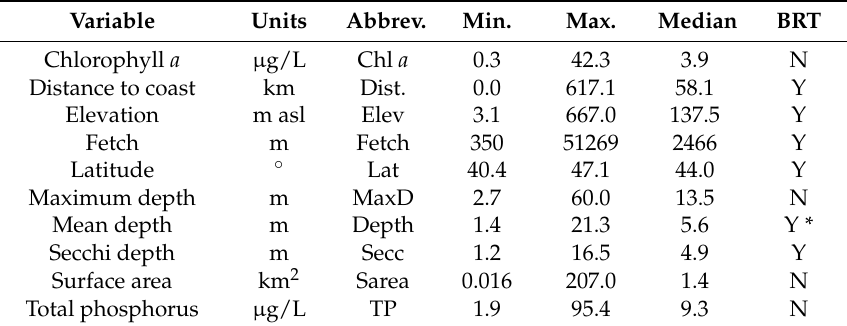
Table 1. Summary of lake variables from this northeastern North American lake study, 1985 cohort. The ranges for the 1975 cohort are consistent with those listed here. See the Materials and Methods for further details. “BRT” indicates if the explanatory variables were included (Y) or not (N) in the boosted regression tree analysis. Variable Units Abbrev.